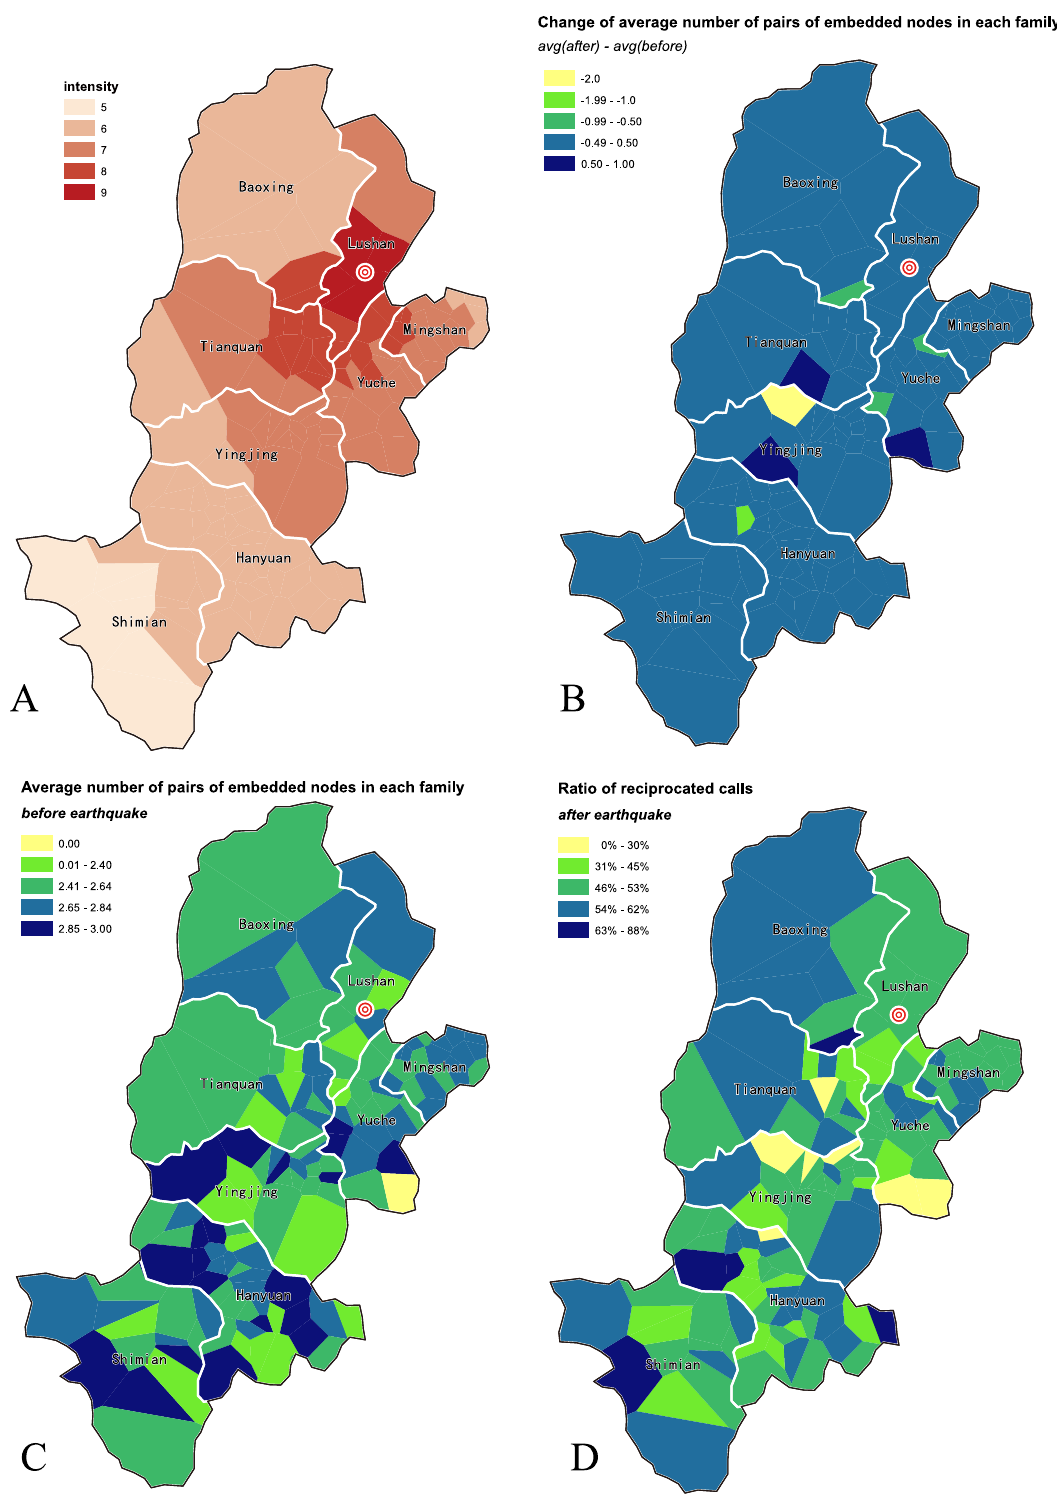
Fig. 3 Geography of earthquake intensity and embeddedness structure. A Earthquake intensity at each geographic locale (town/village level). B Change in structure of embeddedness before vs. after the earthquake at each locale: count of number of pairs of embedded nodes (i.e., embedded edges or links) in families after the earthquake is stable and similar to before the earthquake. C Embeddedness structure 1 – 4 weeks before the earthquake at each locale (average number of family dyads that share a nonfamily friend). D Average ratio of reciprocated calls across locales 2 – 5 weeks after the earthquake. Intensity is not signi fi cantly correlated with embeddedness, Pearson ’ s r = − 0.128, p = 0.138, or reciprocity, r = − 0.106, p = 0.222; embeddedness and reciprocity are signi fi cantly correlated, r = 0.505, p < 0.0001. Overall, embeddedness structure is stable to the earthquake ’ s shock and is correlated with post-earthquake reciprocity